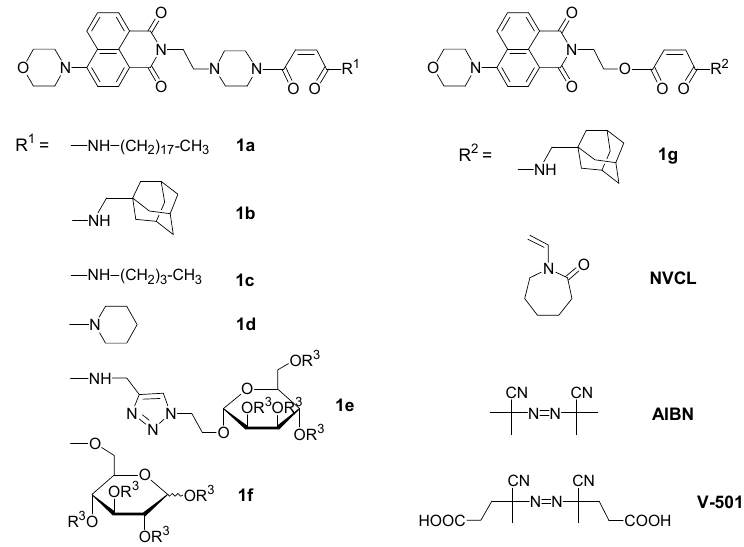
Figure 1. Chemical formula of the dye monomers synthesized, and the monomers and initiators used in the synthesis of fluorophore-functionalized thermo-sensitive polymers. For monomers 1e and 1f , R 3 = acetyl, while, for polymers PNVCL-e and PNVCL-f , R 3 = H. For labeling PNVCL by fluorophores, copolymerization of NVCL with dye-functionalized comonomers is advantageous [13,15], as both the monomer NVCL and the homopolymer are difficult to functionalize. However, NVCL is much less reactive in radical copolymerization than styrenic and